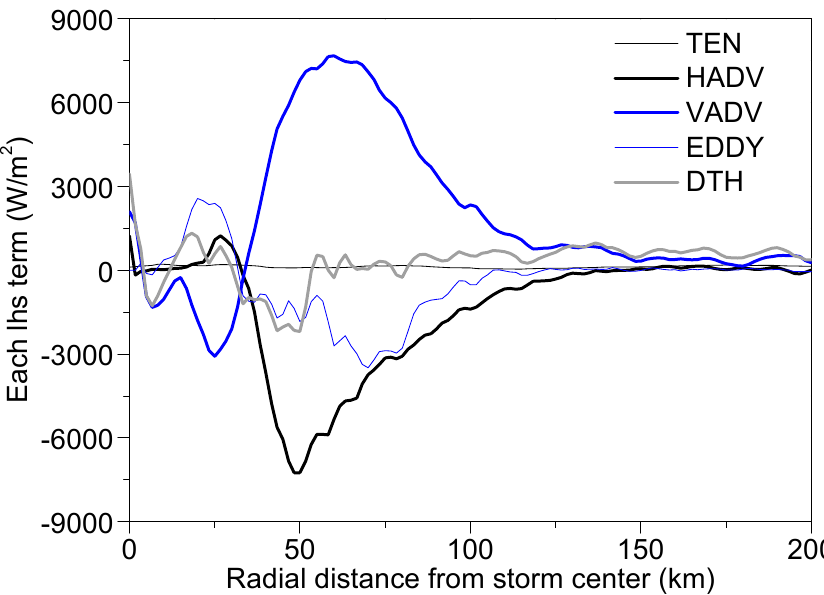
Figure 8. As in Figure 7, but for the upper-troposphere MSE budget for ( a ) lhs and ( b ) rhs terms. Vertical integral is taken from 10 km to the top of the model atmosphere.